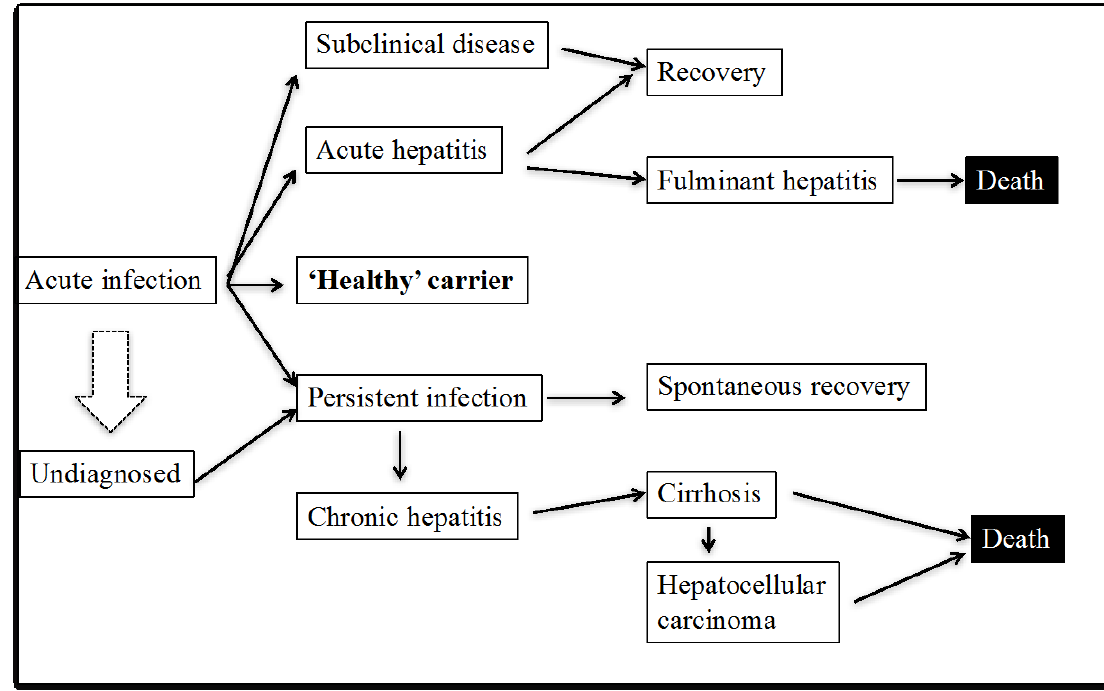
Figure 1. Variations in clinical course of Hepatitis C virus (HCV) infections.